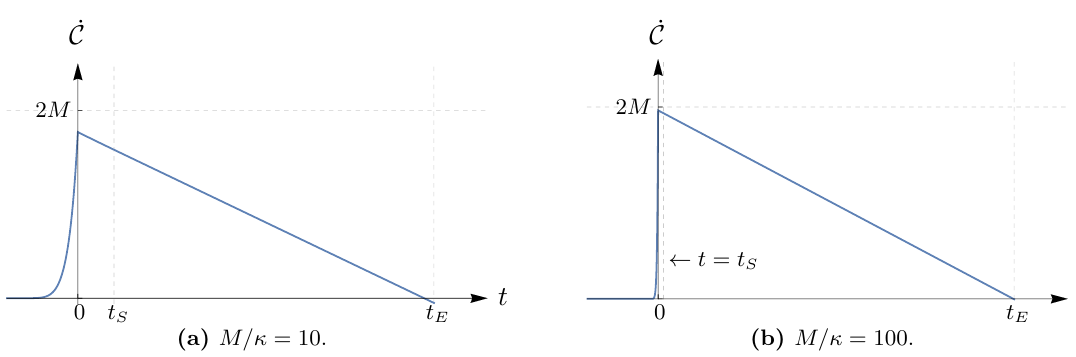
Figure 7 . The growth rate _ C of holographic complexity as a function of tortoise time t , using the CA prescription, for evaporating black holes of di(cid:11)erent initial mass. The exponential onset at the creation time of the black hole is followed by a linear fallo(cid:11) period until the black hole has